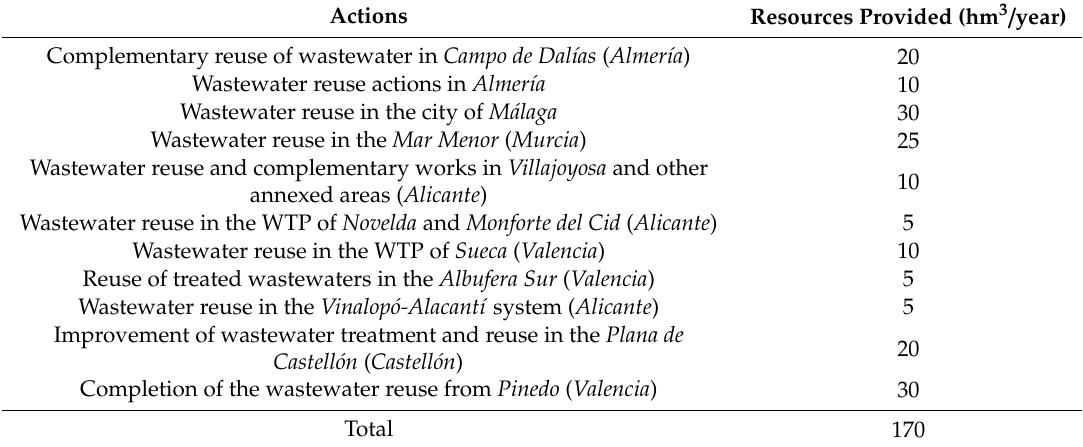
Table 4. Reuse actions under the WATER Programme. Source: own elaboration based on [26,63,65]. Actions Resources Provided (hm 3 / year) Complementary reuse of wastewater in Campo de Dal í as ( Almer í a ) 20 Wastewater reuse actions in Almer í a 10 Wastewater reuse in the city of M á laga 30 Wastewater reuse in the Mar Menor ( Murcia ) 25